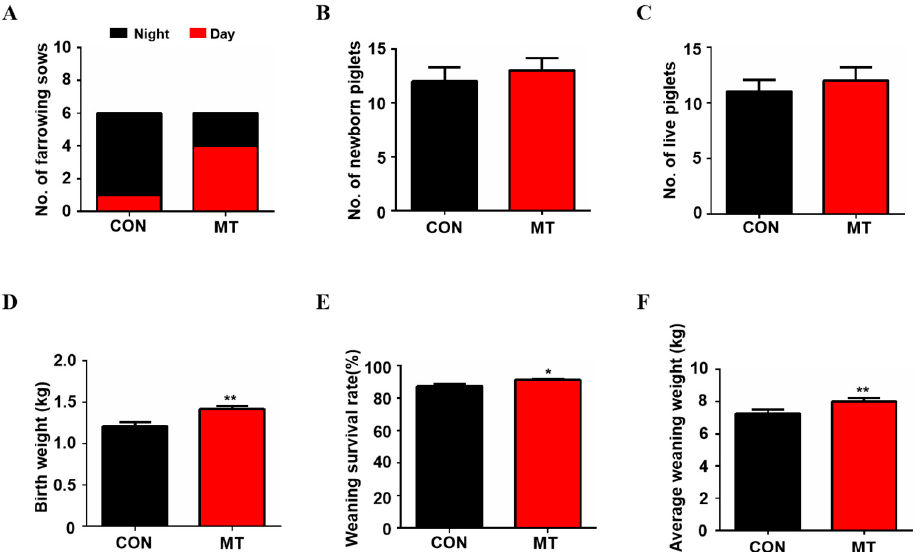
Figure 2. Reproductive Performance of sows with melatonin supplementation. ( A ) The number of sows giving birth during the day and night ( n = 6). ( B ) The average number of newborn piglets ( n = 5 for CON, n = 6 for MT group). ( C ) The average number of born alive ( n = 5 for CON, n = 6 for MT group). ( D ) Average birth weight of piglets ( n = 55 for CON, n = 72 for MT group). ( E ) Average weaning survival rate ( n = 5 for CON, n = 6 for MT group). ( F ) Average weaning weight of piglets ( n = 30 for CON, n = 36 for MT group), to avoid the stress of all piglets during weighing and affecting their growth, only six piglets from each sow were randomly selected for weighing). Data are presented as means ± SEM. * p < 0.05. ** p < 0.01. CON = control, MT =